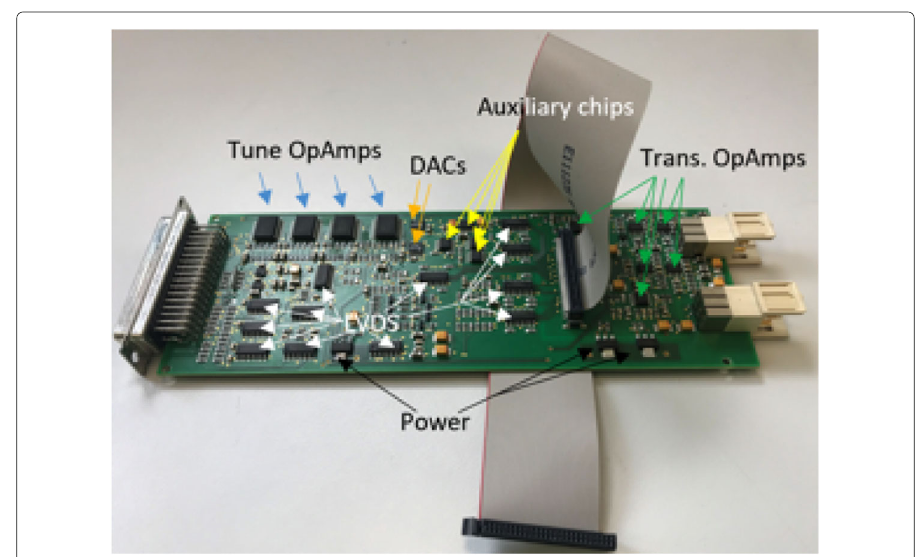
Fig. 16 Repeater card with references to its main components